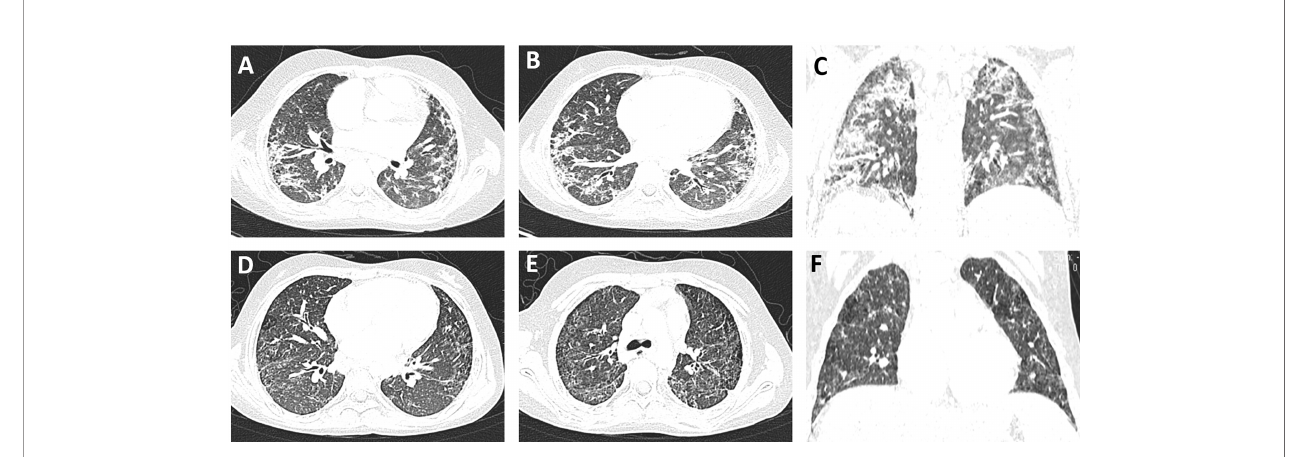
FIGURE 2 | Pulmonary imaging changes of the patient with systemic lupus erythematosus (SLE)/Sjogren ’ s syndrome (SS) and NMOSD. (A – C) In December 2019, the texture of both lungs was slightly increased and disorganized, and the diffuse distribution of high-density shadows in both lungs was rod-shaped and fl aky, some of which were grid-shaped with blurred edges. The cystic transparent shadows could be seen in both upper lungs, no abnormality was observed in the hilar area of both lungs, and multiple enlarged lymph nodes could be seen in the mediastinum. After the anti-infection treatment with meropenem and teicoranin, the exudation of both lungs was signi fi cantly reduced 1 month later (D – F) , while signi fi cant lung interstitial lesions still